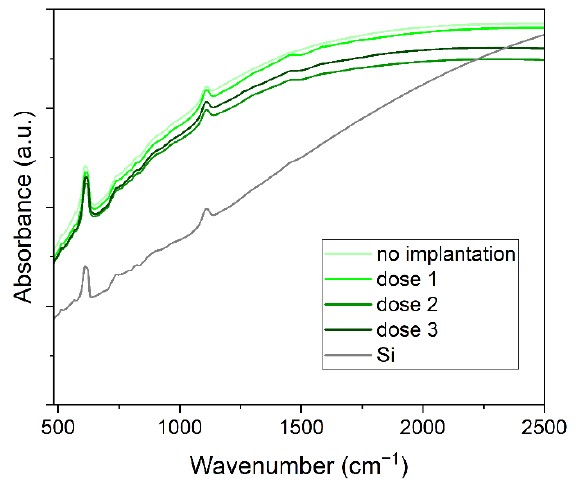
Figure 9. Absorbance of Cu 2 O samples and Si substrate measured with infrared spectroscopy.